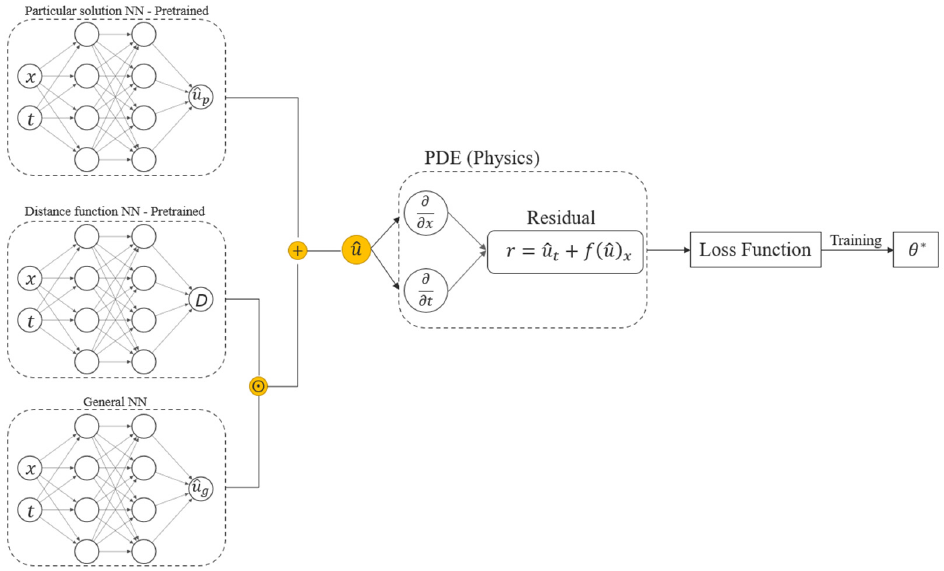
Figure 4. Data-free composite PINN architecture for the solution of the hyperbolic Buckley–Leverett problem. Note: the backbone of the model could be an MLP or an attention model and the I/BCs are enforced in a hard manner.